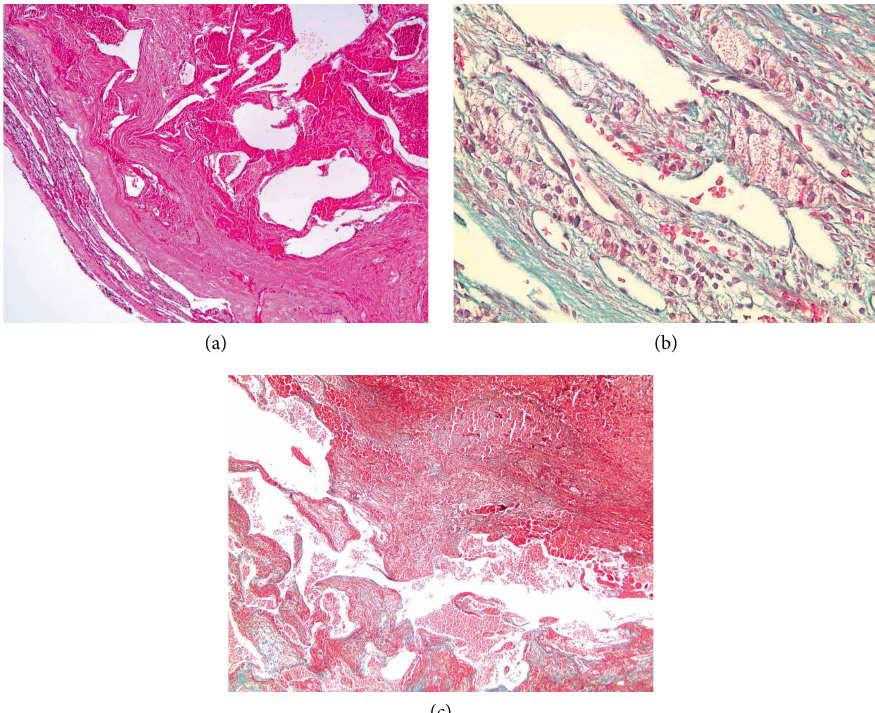
Figure 2: Histopathological images of an adrenal cavernous hemangioma cross section, showing dilated capillaries with capsule and significant fibrosis on Hematoxylin and Eosin (H&E) staining (a). Magnified image showing red blood cells inside dilated capillaries (b), divided by thick fibrous septa